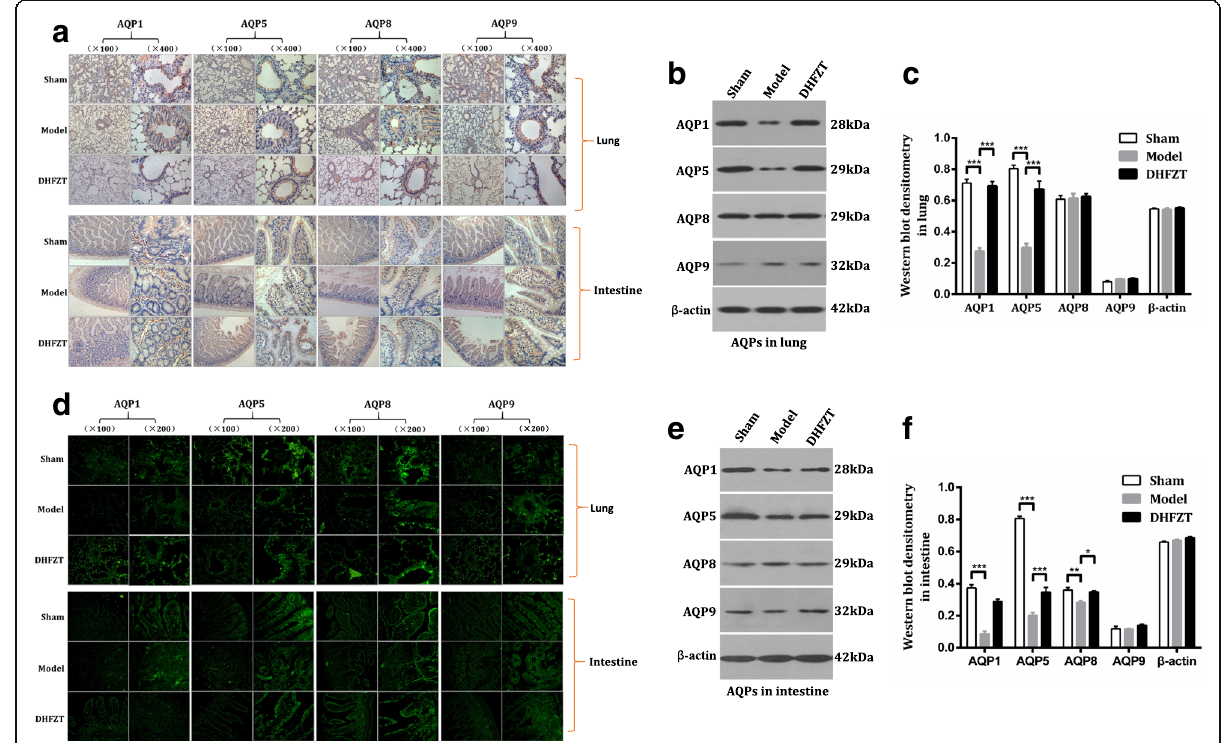
Fig. 5 DHFZT regulated the expression of AQPs in lung and intestine after SAP in rats. a : distribution and expression of AQPs in lung and intestine at 48 h post-operation by immunohistochemistry (IHC). b and c : AQPs expression levels in lung by western blot analysis. d : expression of AQPs in lung and intestine at 48 h post-operation by immunofluorescence (IF). e and f : AQPs expression levels in intestine by western blot analysis. * P < 0.05, ** P < 0.01, *** P <